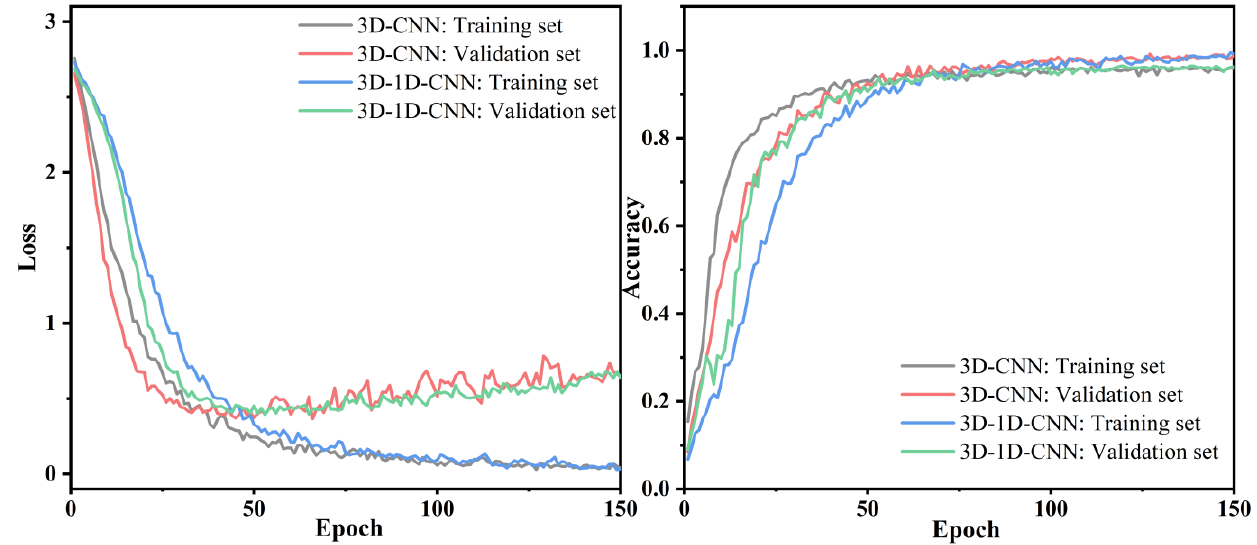
Figure 18. Comparison of accuracy loss curves of different models on the Houston dataset.